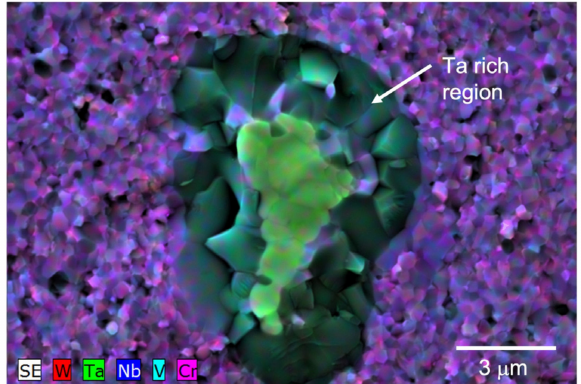
Figure 6. EDS compositional mapping of the Ta-enriched phases in the fracture surface of CrNbTaVW high entropy